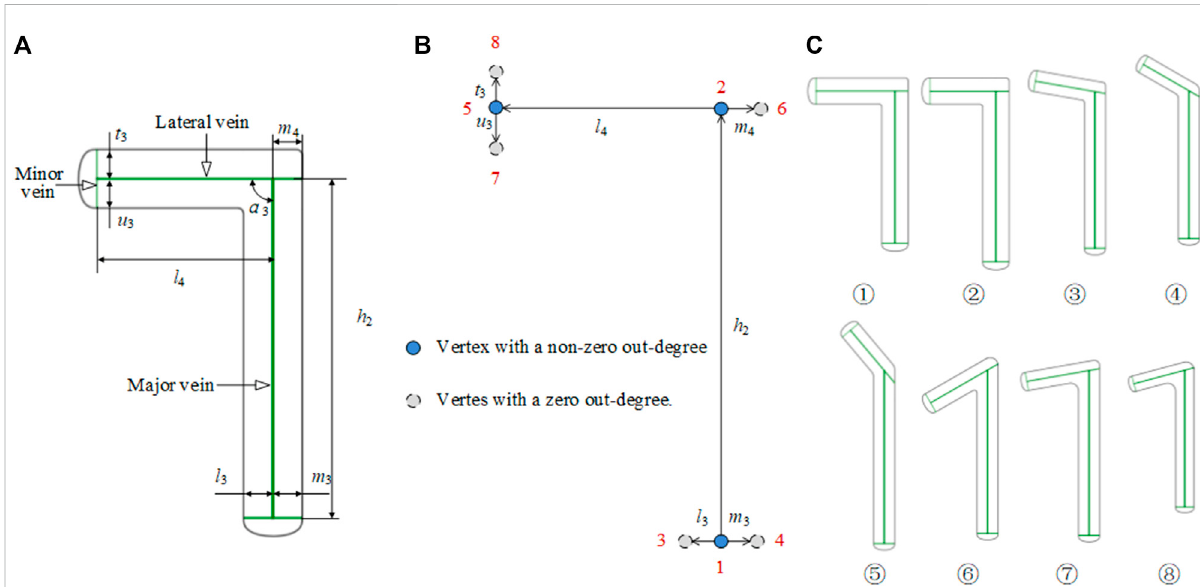
FIGURE 6 Bionic vein structure features of the L-shaped plate. (A) Semantic parameters of L-shaped bone plate, mainly refers to the length of veins and theanglebetweenveins. (B) Weighted digraphofL-shaped boneplate.Verticesare numberedfrom thebottomto thetop andfromleftto right. The morphological and dimensional adjacency matrices corresponding to the digraph are M 3 and M 4 respectively (C) Bionic vein structure features of customizedL-shaped plates. Bymodifyingsemantic parametersin (A) , M 3 and M 4 are updated, and then differentbionic veinstructure features are generated.